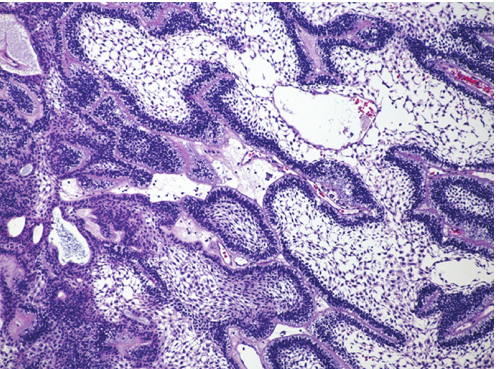
Figure 3: Columnar cells that displayed palisading with classic basaloid (“follicular”) appearance and reverse polarity lined the periphery of the